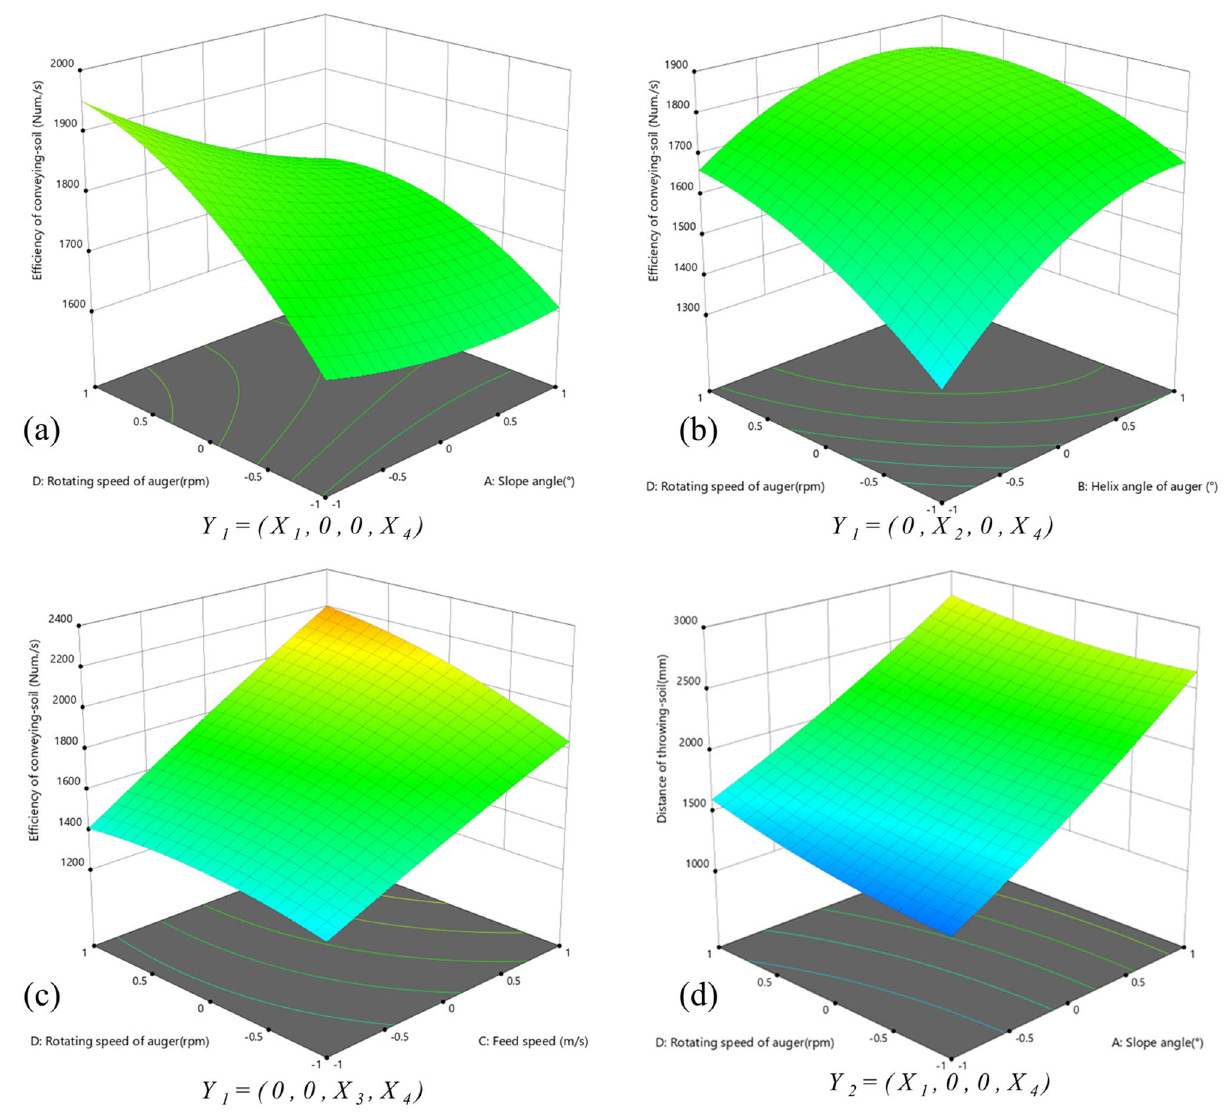
Figure 8. 3D response diagram effect of evaluation indices. ( a ) Effect of interaction between X 1 and X 2 on efficiency of conveying-soil. ( b ) Effect of interaction between X 2 and X 4 on efficiency of conveying-soil. ( c ) Effect of interaction between X 3 and X 4 on efficiency of conveying-soil. ( d ) Effect of interaction between X 3 and X 4 on distance of